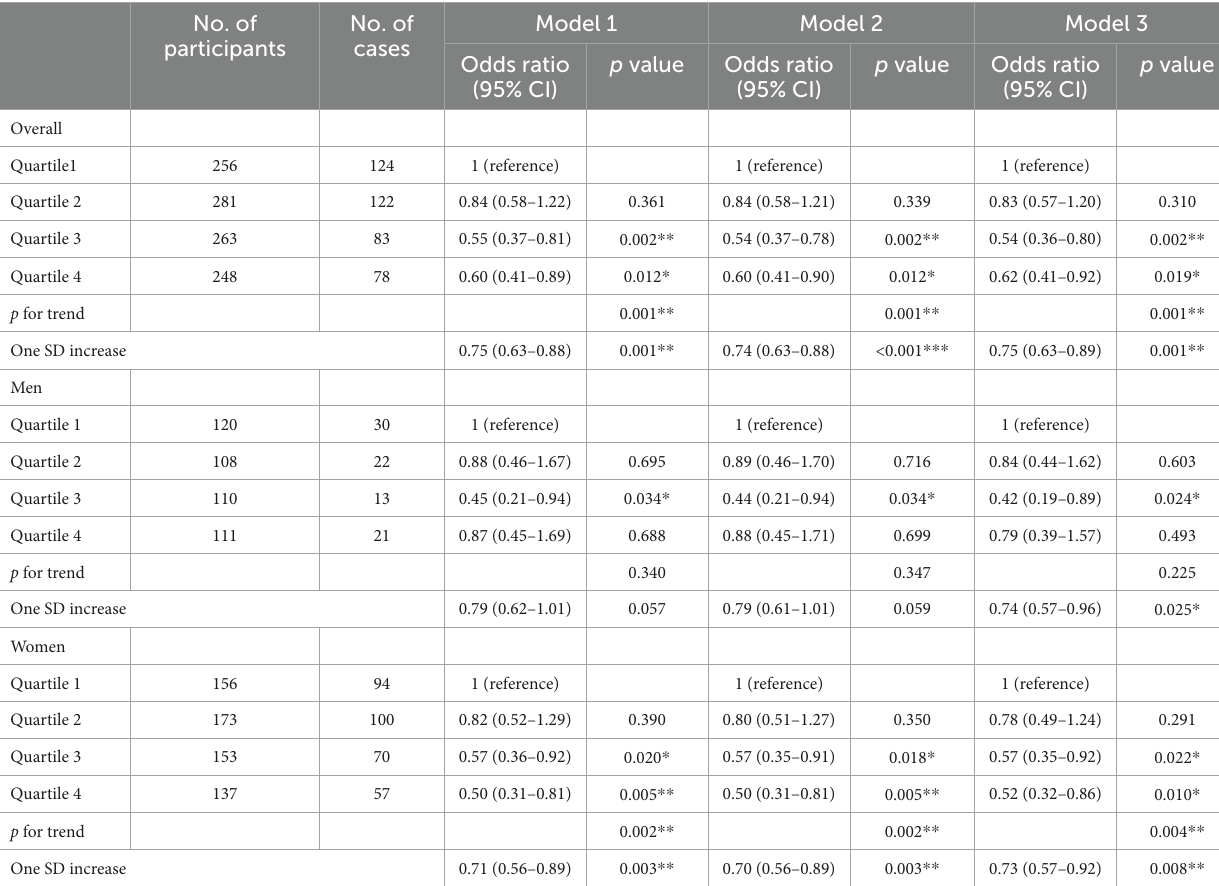
TABLE 4 Relationship between Hb quartiles and risk of OP after gender stratification and